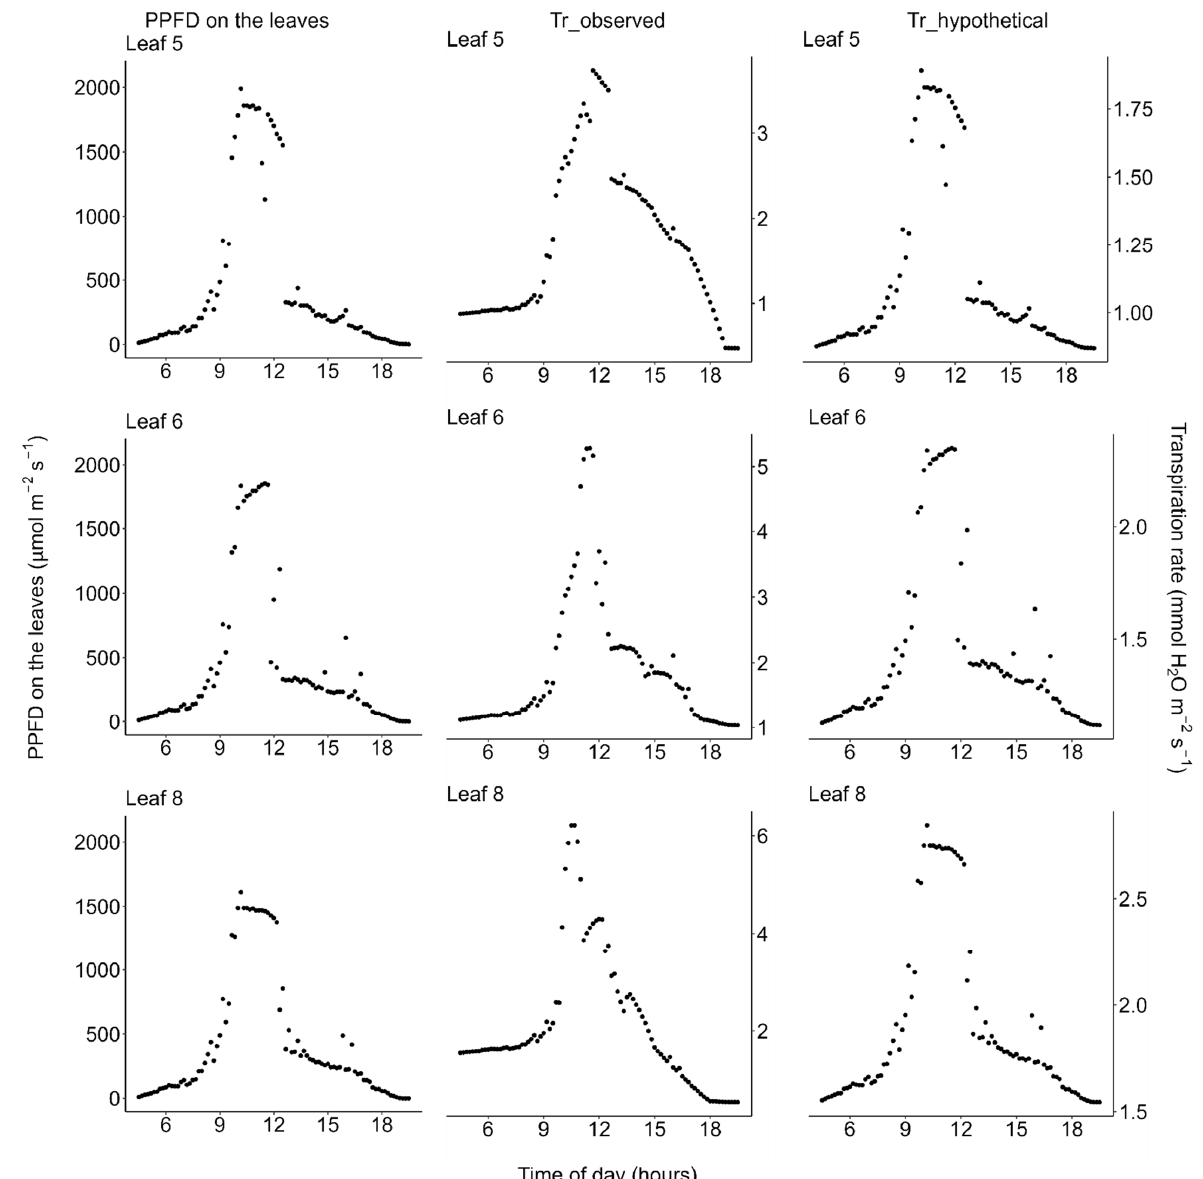
Figure 8. Diurnal courses of transpiration on the moderately hot days (22 and 23 July 2021). ( Left ) Photosynthetic photon flux density (PPFD) incident on each leaflet of Menyanthes trifoliata , ( middle ) T r_observed : actual transpiration rate per unit area of leaf calculated based on both the observed diurnal change of the PPFD-transpiration response curve (Figure 5) and the diurnal change of PPFD, and ( right ) T r_hypothetical : simulated transpiration rate calculated by holding the PPFD-transpiration response curve constant throughout the day, fixed at the curve observed in the early morning for each leaflet (Figure 5). Note that: (1) PPFD was measured on 23 July and the PPFD data were used to estimate transpiration on 22 July, the day on which light-response curves shown in Figure 5 were measured; and (2) in the afternoon, the plants were shaded by trees on the pond shore (see Figure 1 for detailed weather conditions). All data are available in the Supplementary